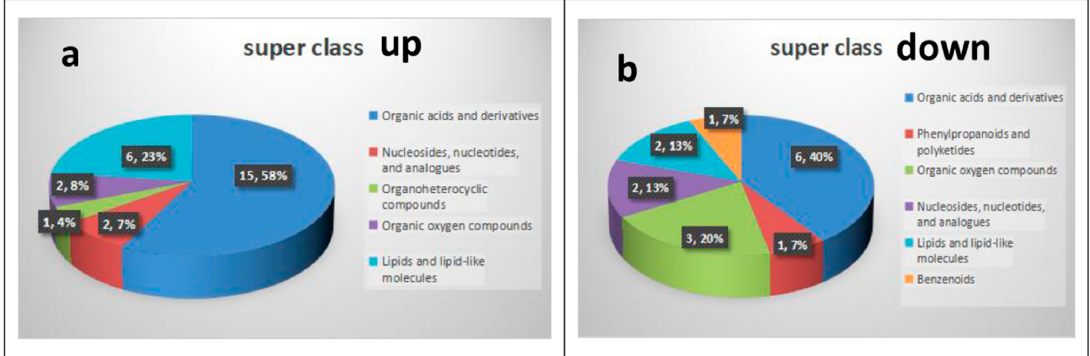
Figure 5. Statistical chart of upregulated ( a ) and downregulated differential metabolites ( b ). Table 1. Upregulation of differential metabolites and their